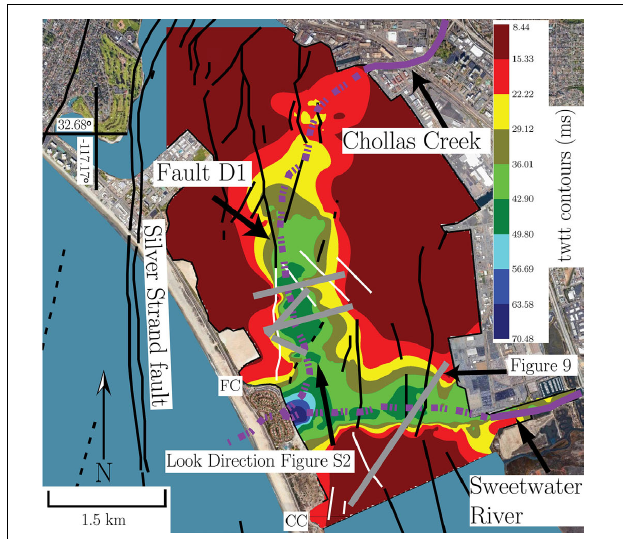
FIGURE 7 | Gridded surface showing base of paleochannel horizon observed in combined MCS and Chirp dataset (e.g., Figures 4 , 9 , Supplementary Figures 2 , 3 ). Previously mapped faults are shown in black (USGS, 2019), newly mapped faults in white. Purple dashed lines are the approximate locations of paleochannels. Grey lines are locations of Chirp profiles. FC, Fiddlers Cove; CC, Crown Cove. Background satellite image from Google Earth